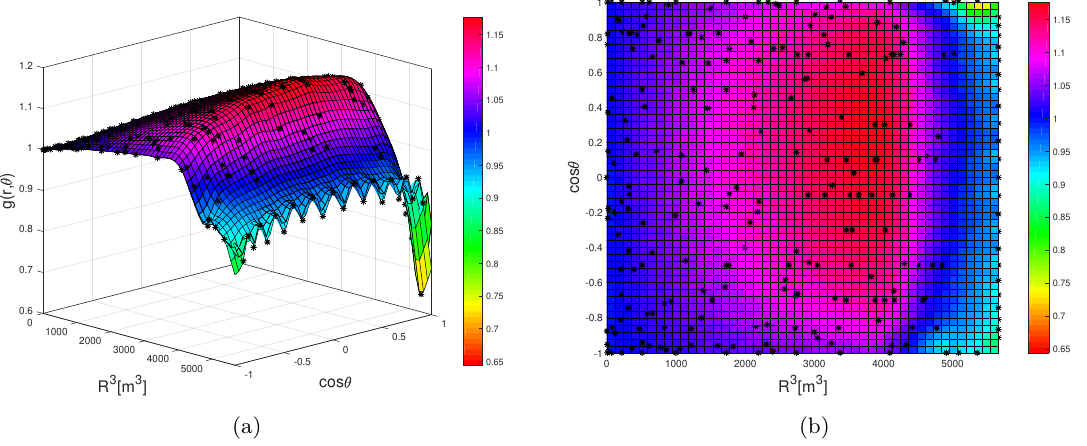
Figure 11 . The non-uniformity g ( r, θ ) in φ = 0 plane as a function of cos θ and R 3 , (a) 3D surface, (b) 2D projection with value of g indicated by the color band. The black points are the optimized deployment locations of calibration sources as explained in section